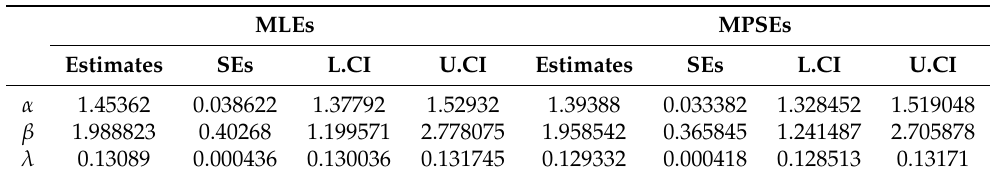
Table 7. Estimates, SEs, L.CI, and U.CI using the ML and modified MPS methods for complete bladder cancer data.